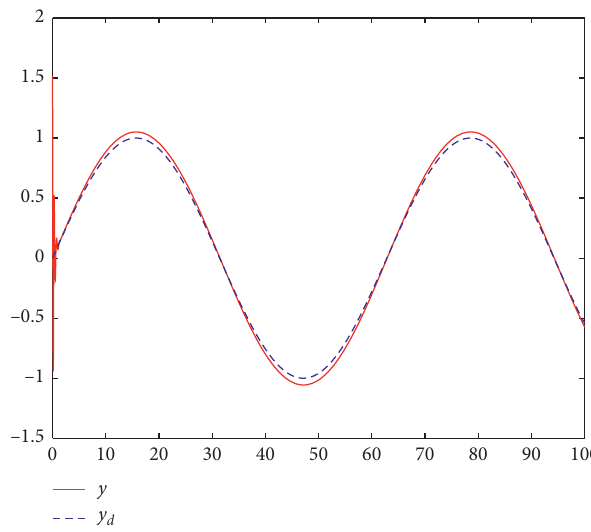
Figure 1: The responses of the system out y ( t ) and reference signal y d of the